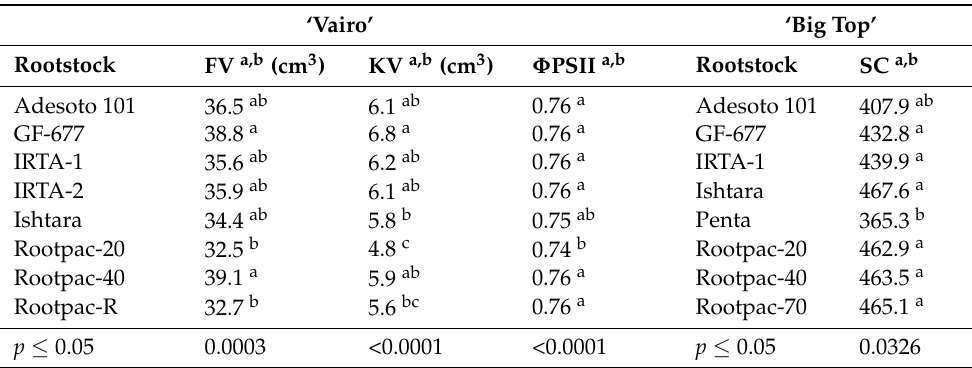
Table 3. Agronomical and physiological assessments made before harvest, corresponding to eight- year-old ‘Vairo’ almond trees and ten-year-old ‘Big Top’ nectarine trees grafted onto eight different Prunus rootstocks.